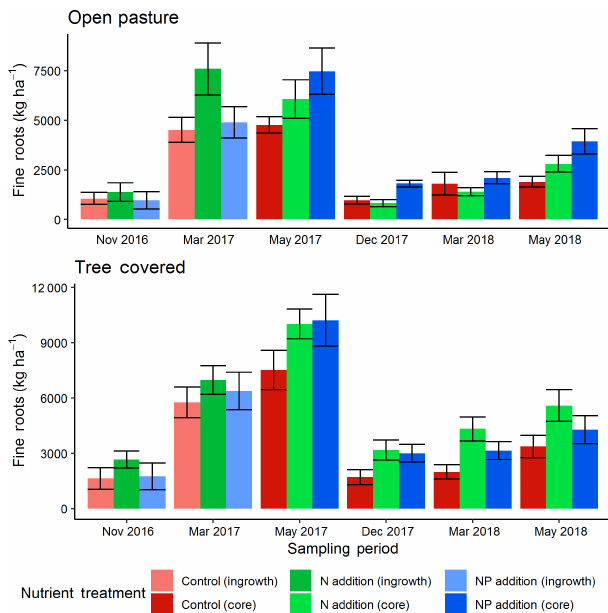
Figure 6. Fine root biomass in the top 13cm from direct soil cores (November 2016 and March 2017) and ingrowth cores (installed installed November 2017, removed March 2018 and May 2018). Root biomass showed a seasonal cycle and also differences between treatments, with more roots in general under canopies and in fertil- ized plots. Error bars show value ± SE and letters indicate Tukey HSD groupings for most parsimonious models within treatment for both open-pasture and tree-covered microhabitats combined in indi- vidual sessions. Both +N and +NP treatments tended to have more root biomass than control treatments. Across the whole dataset, +N had significantly ( P < 0 . 05) more fine roots than the other two